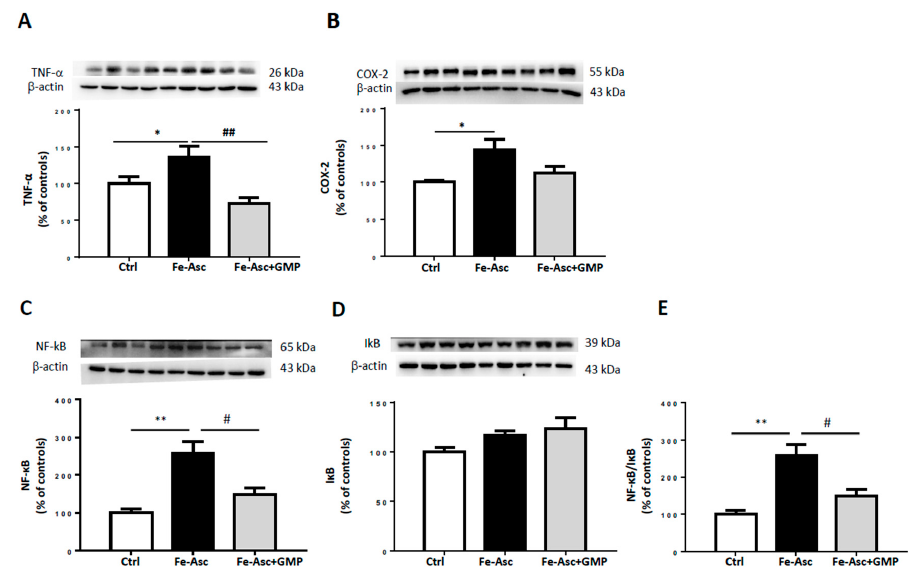
Figure 3. Effects of GMP on inflammation in Caco-2/15 cells. Caco-2/15 cells were pre-incubated for 18 h before treatment with Fe/Asc (200 μ M/2 mM) +/- GMP (2 mg/mL) for 6 h at 37°C as described in Materials and Methods. Protein expression of the inflammatory biomarkers ( A ) Tumor necrosis factor alpha (TNF- α ), ( B ) Cyclooxygenase-2 (COX-2), ( C ) Nuclear transcription factor-kappa B (NF- κ B), and ( D ) Inhibitor of kappa B (I κ B) was determined by Western blot. ( E ) The NF- κ B / I κ B ratio was calculated. Results represent the means ± SEM of n = 3 independent experiments in triplicate. * p < 0.05, ** p < 0.01 vs. controls (Ctrl). # p < 0.05, ## p < 0.01 vs Fe / Asc-treated cells.